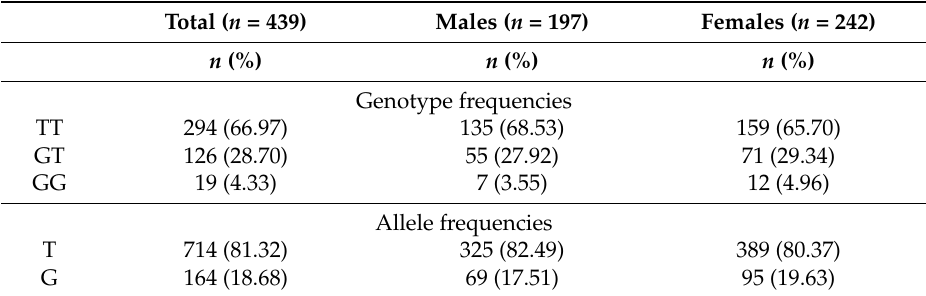
Table 1. Allele and genotype frequencies of tumor necrosis factor receptor-II ( TNF-RII ) rs1061622 in the study population.